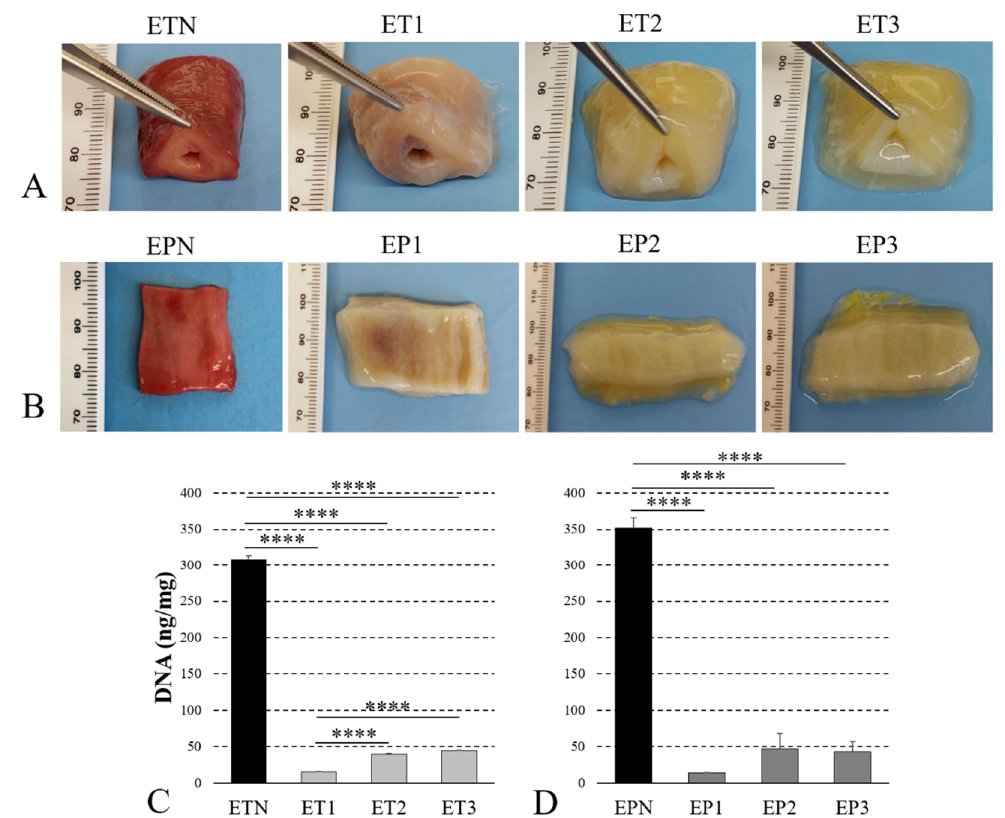
Figure 1. Decellularization efficacy. Gross appearance ( A , B ) of esophageal tubules (ETs) and patches (EPs) before (ETN, EPN) and after decellularization with Protocols Nos. 1 (ET1, EP1), 2 (ET2, EP2) and 3 (ET3, EP3). Quantification of residual DNA ( C , D ) into decellularized versus native samples (**** p < 0.0001).